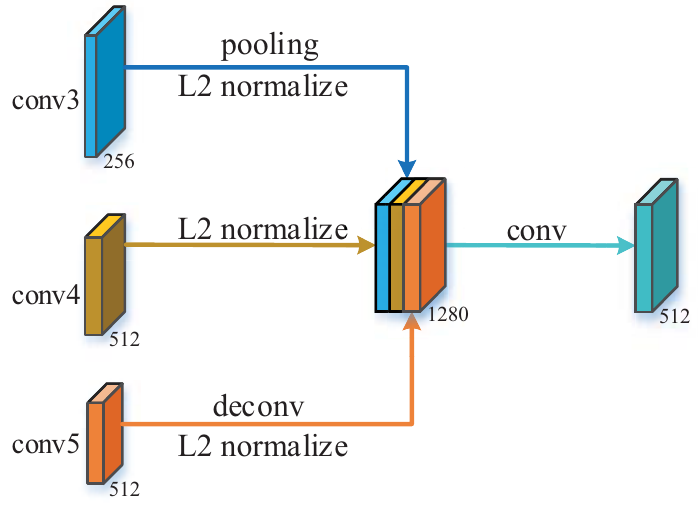
Figure 3. Multi-scale feature fusion